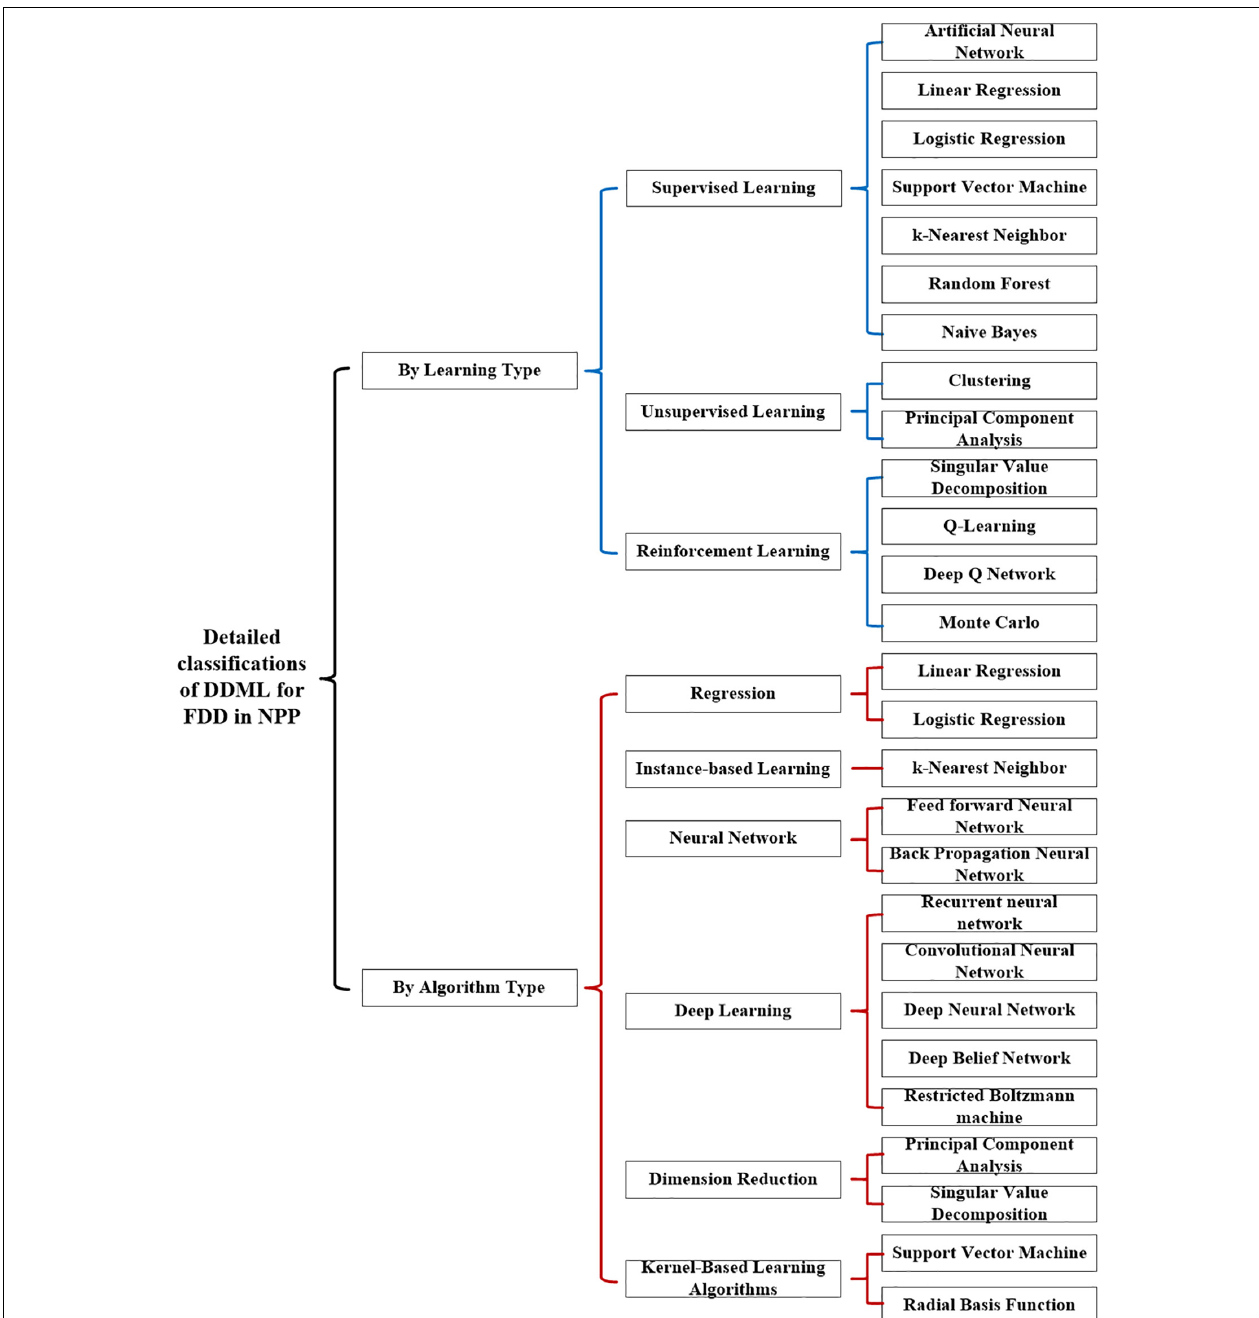
FIGURE 1 | Detailed classifications of data-driven machine learning (DDML) for the fault diagnosis and detection (FDD) in the nuclear power plant